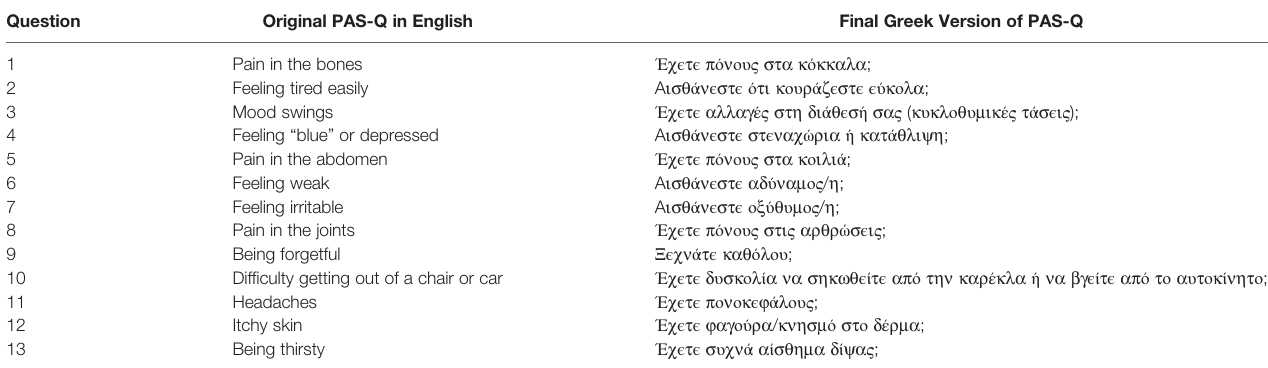
TABLE 2 | The original and the fi nal translated version of PAS-Q in Greek.